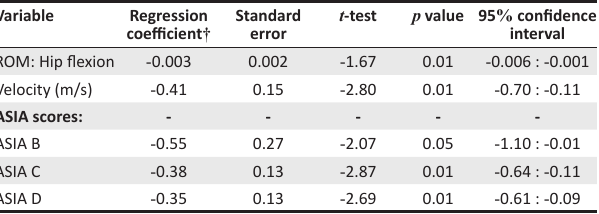
TABLE 5: Multivariable analysis results for factors which had an influence on energy expenditure during walking.